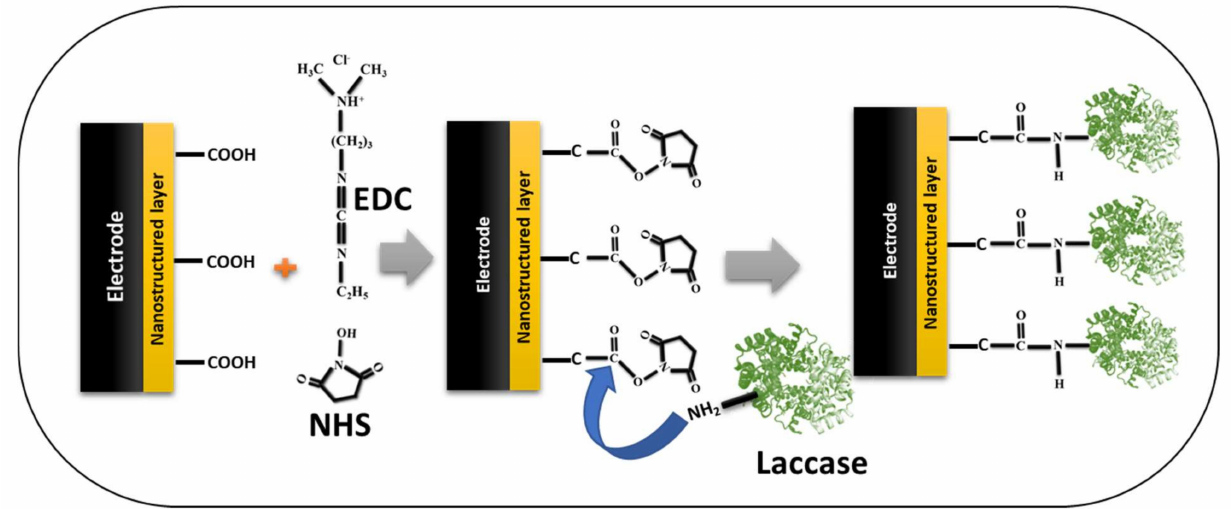
Figure 11. Schematic presentation of the EDC/NHS-based strategy of covalent immobilization of the laccase on the nanostructured-electrode/sensor platform in laccase-based